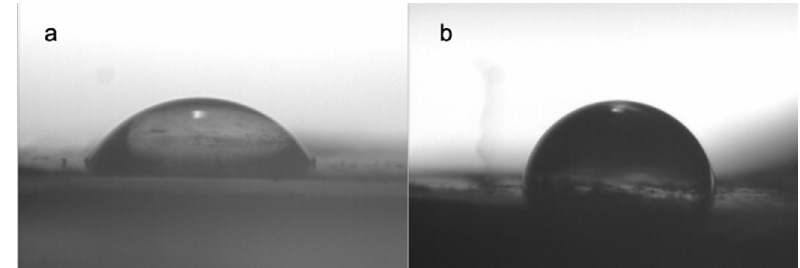
Figure 3: Contact angle with water of GO: ( a ) before grafting and ( b ) after grafting.